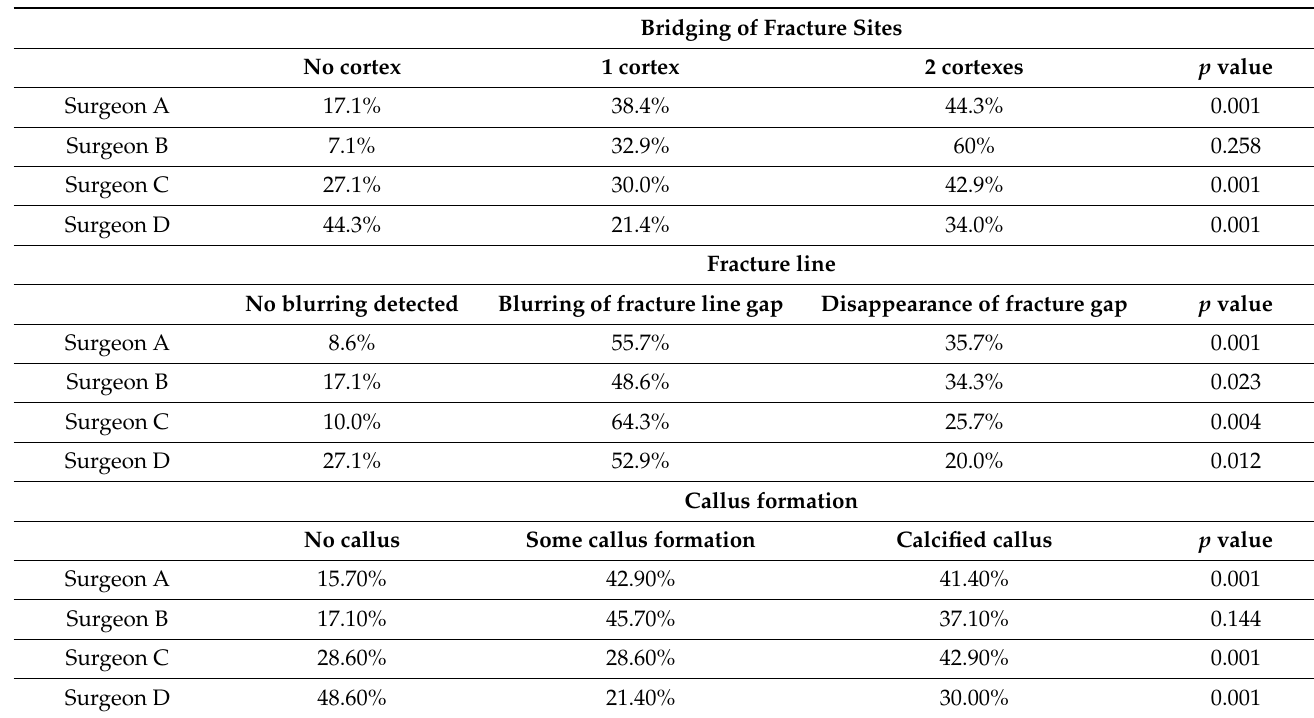
Table 2. Percentage of division between different parameters in all surgeons